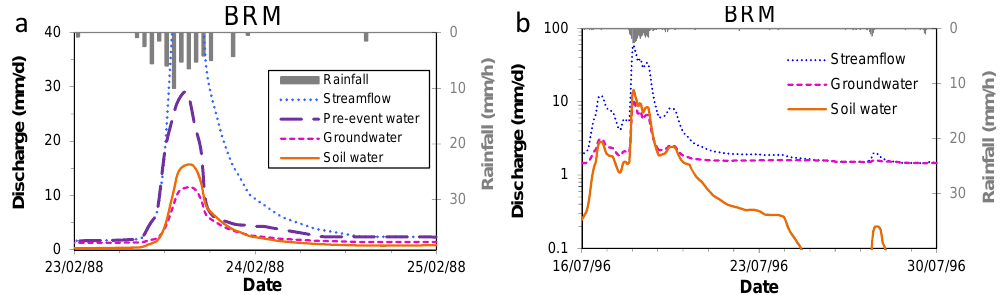
Figure 7. (a) and (b) showing groundwater and soil water components of the baseflow matched to the pre-event hydrograph. Streamflow is pre-event water plus event